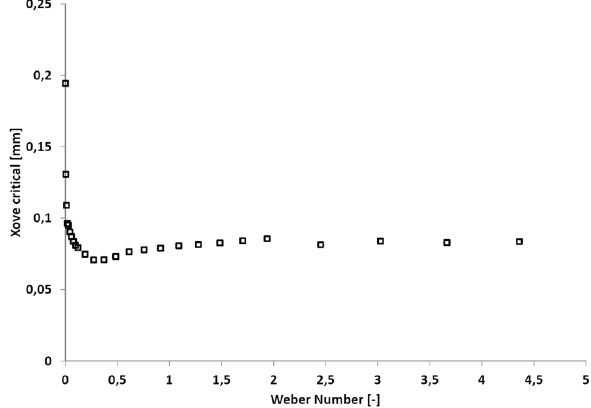
Fig. 12 Critical value of X H = 12 µm and p gap